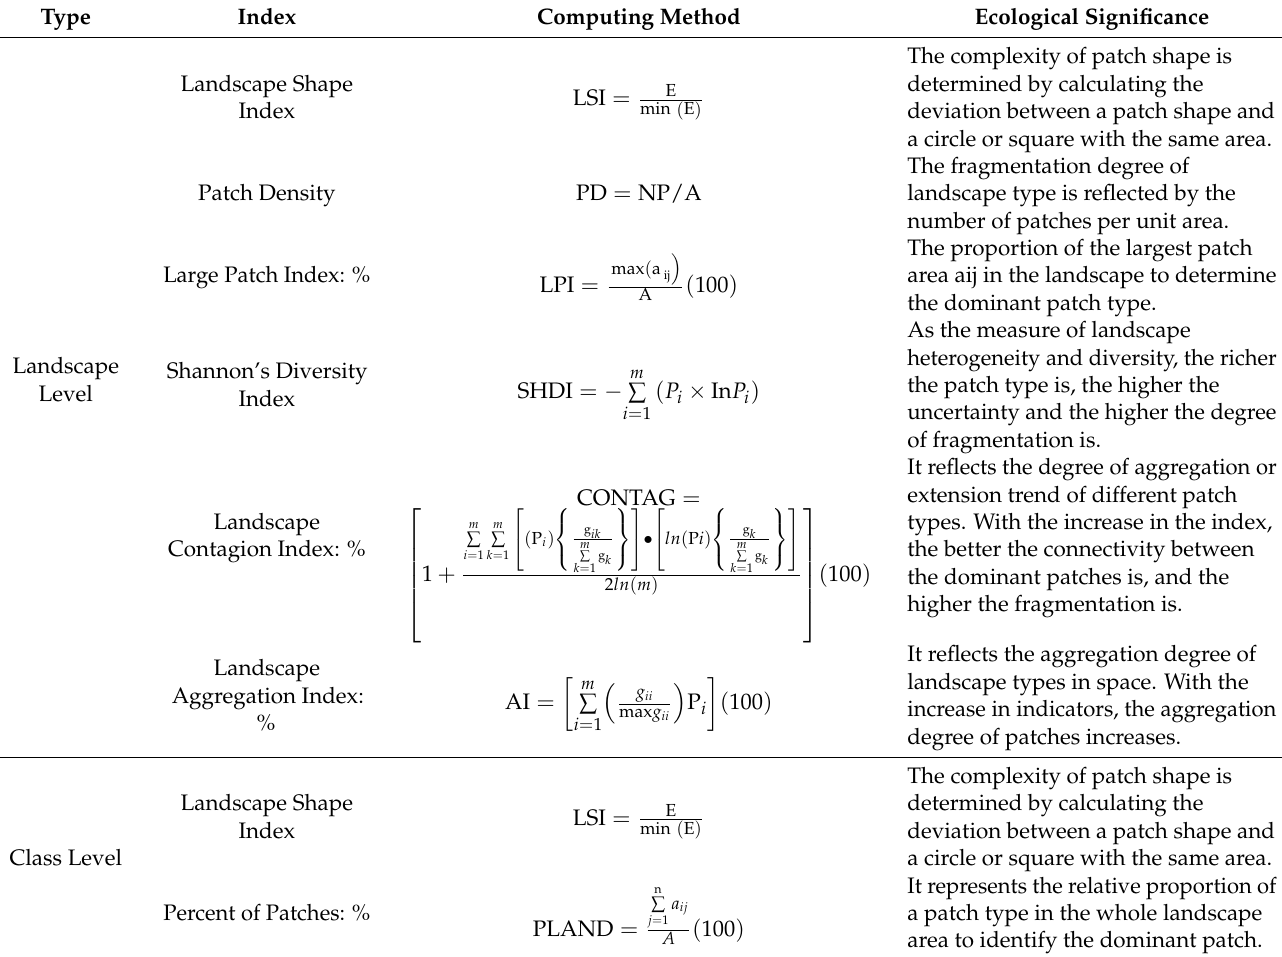
Table 2. Landscape pattern index and basic